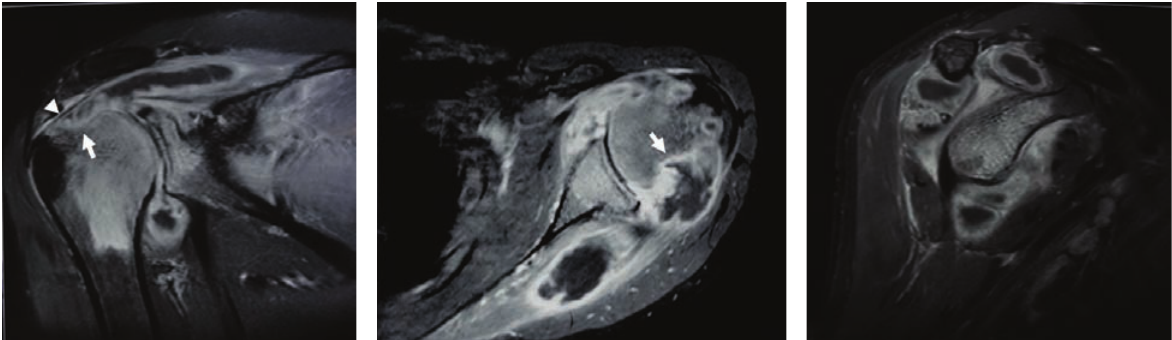
Figure 5: MRI demonstrating a large abscess surrounding the humeral head and extending into the supraspinatus and infraspinatus muscle substance. Significant bone erosion in the superior portion of the humeral head (white arrow) and thinning of the supraspinatus tendon (white arrow head) were